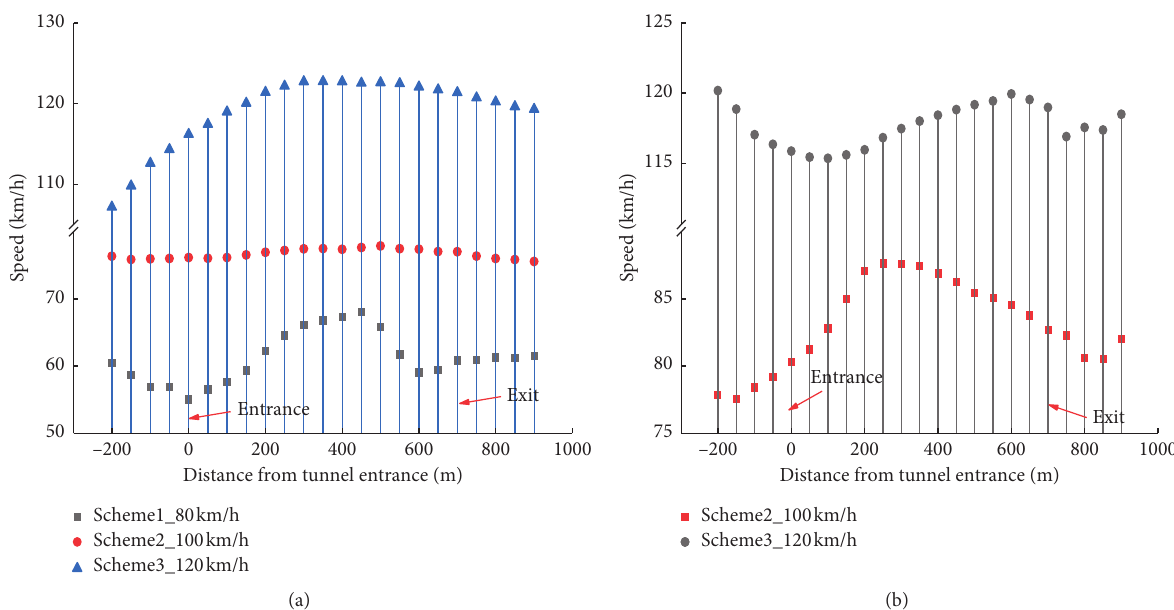
Figure 7: Speed changes for different design speeds. (a) Left lateral clearance. (b) Right lateral clearance.